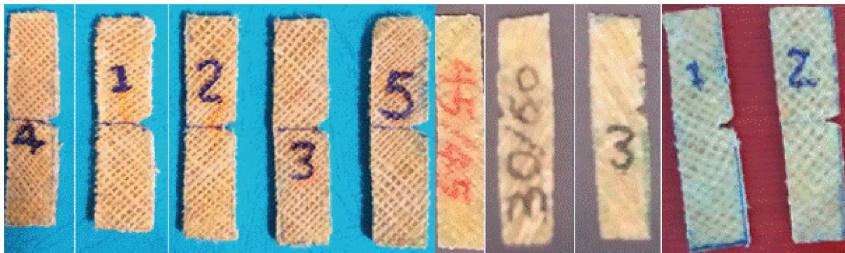
Figure 6: Prepared specimens according to ASTM D256.